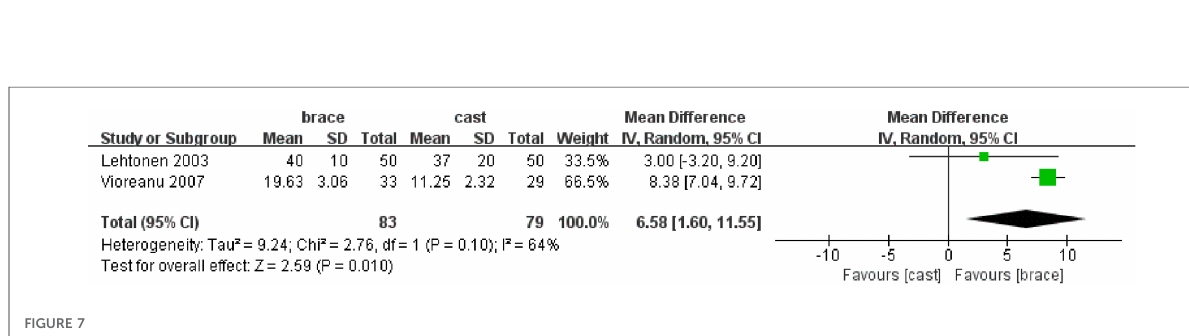
− 9.59, 95% CI − 39.81 to 20.63, I 2 = 98%, p = 0.53; better ankle dorsi fl exion (mean difference 6.78, 95% CI 0.56 –